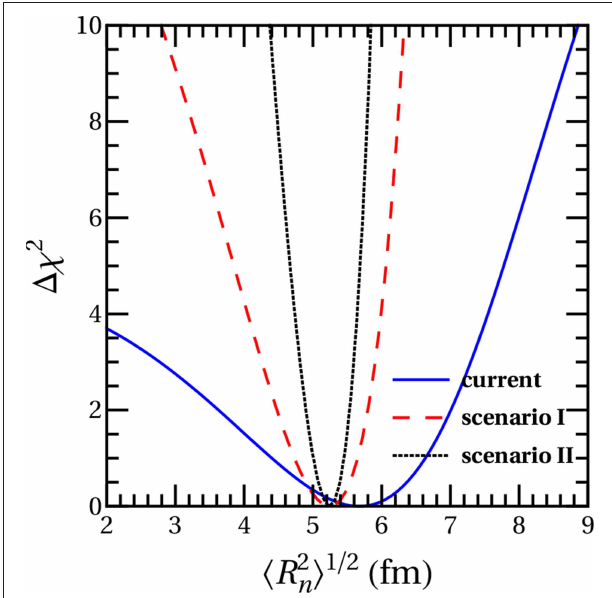
FIGURE 9 | COHERENT sensitivity on the average nuclear rms radius of CsI assuming the current and possible future detector specifications. Taken from Papoulias et al. [